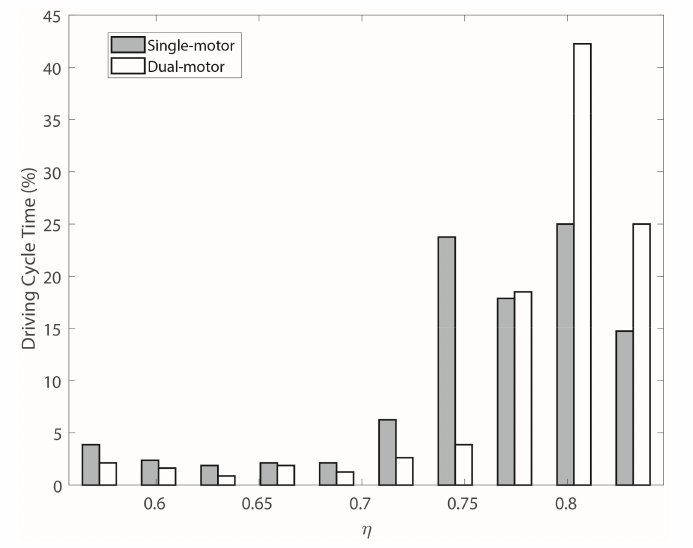
Figure 10. Distribution of the driving cycle time as a function of the efficiency for the single- and dual-motor power transmissions.